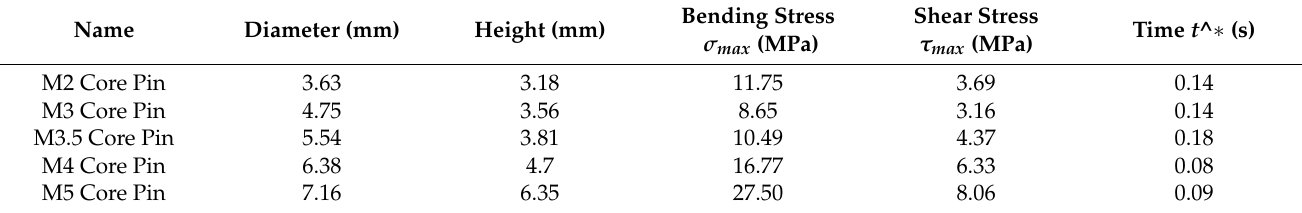
Table 6. Peak bending stress and shear stress on the core pin and the time at which it